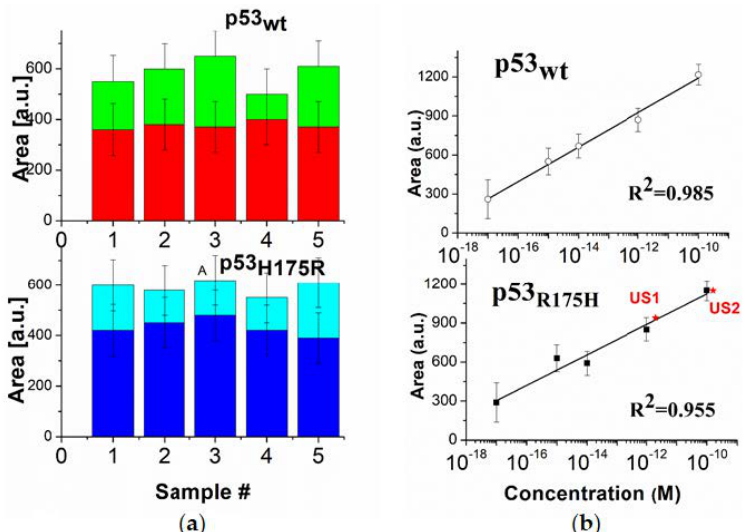
Figure 10. ( a ) Average integrated area of the Raman peak detected at 1328 cm − 1 for p53 wt (top), in bu ff er (green) and in serum (red), and for p53 R175H (bottom) in bu ff er (azur) and in serum (blue) for five di ff erent p53 samples. The average and the corresponding standard deviations (bars) were derived from ten spectra acquired at di ff erent regions of the sample. ( b ) Calibration plot obtained from the average integrated area of the Raman peak at 1328 cm − 1 , as a function of the logarithm of the p53 wt concentration (full squares) and of p53 R175H concentration (open circles). The average and the corresponding standard deviation were obtained from ten spectra acquired at di ff erent regions of the sample. The continuous lines represent the fit by the equation Y = A + BX (for the extracted values see the text); the resulting adjusted R 2 values being reported. The red stars mark the integrated area as obtained for two unknown samples containing p53 R175H (see also ref. [40]).